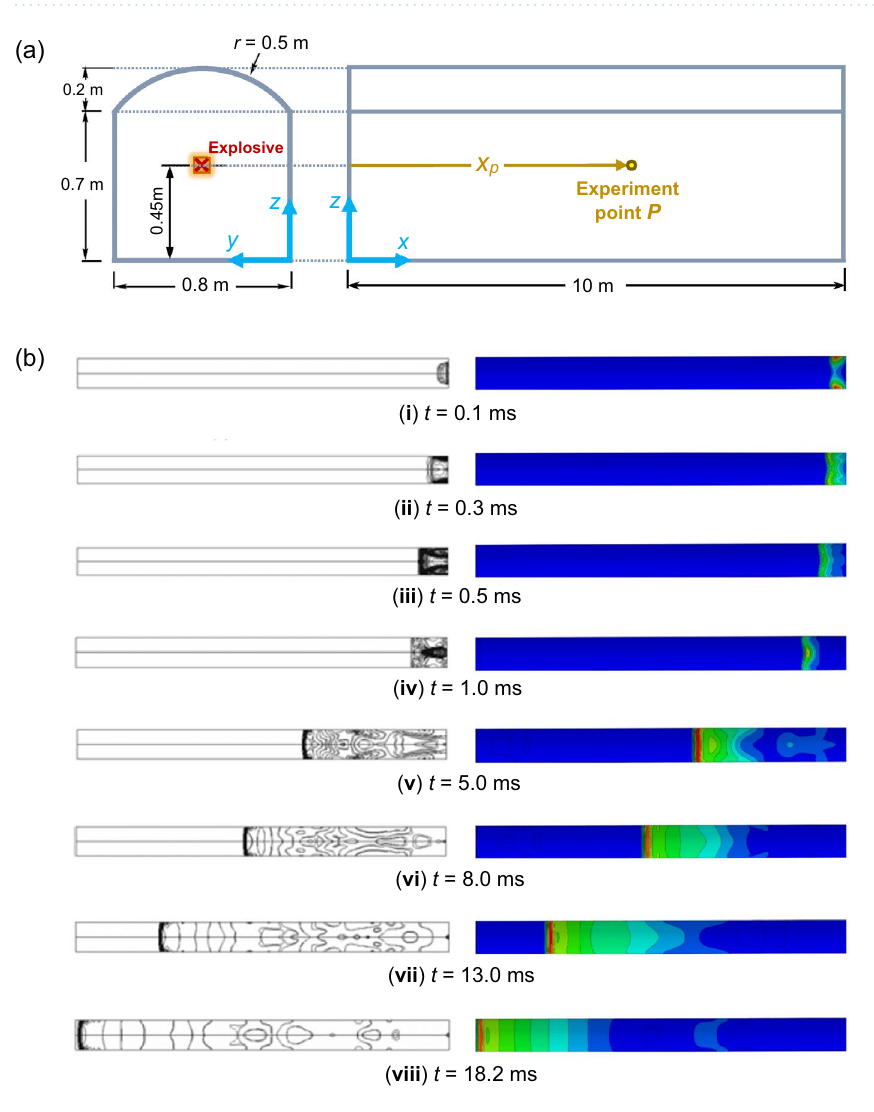
Figure 3. ( a ) Cross-sectional and profile views of the tunnel model (adapted from Liu et al. 26 ). ( b ) Pressure contours at different time steps. Left: FEA results in LS-DYNA reported by Liu et al. 26 ; right: FEA results of the ABAQUS numerical simulations of the present